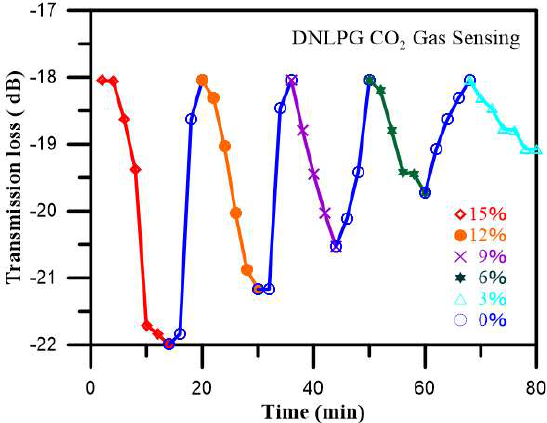
Figure 10 . The online monitoring diagram of the 15%, 12%, 9%, 6%, and 3% CO 2 gas concentrations over three cyclic experiments.